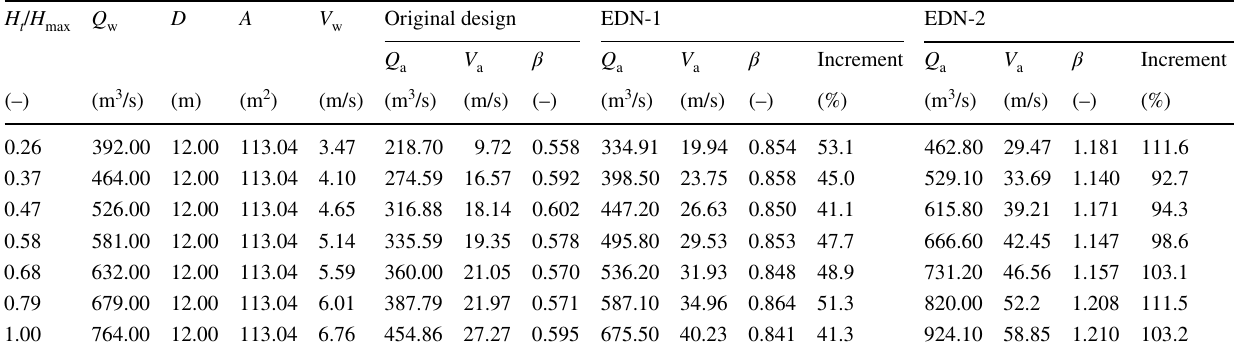
Table 3 Comparison of aeration performance of the original and enhanced designs